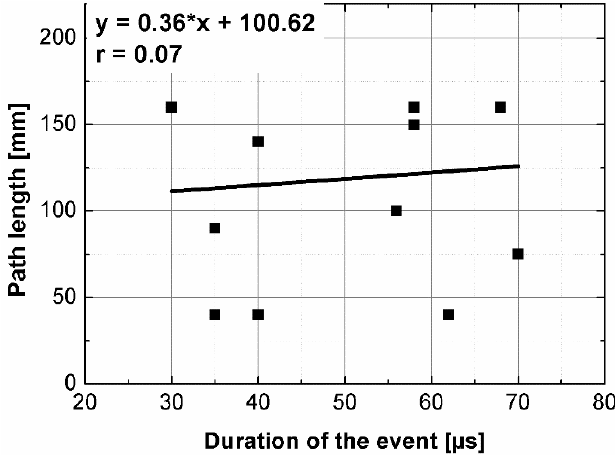
Figure 18. The duration of the main event plotted against path length.